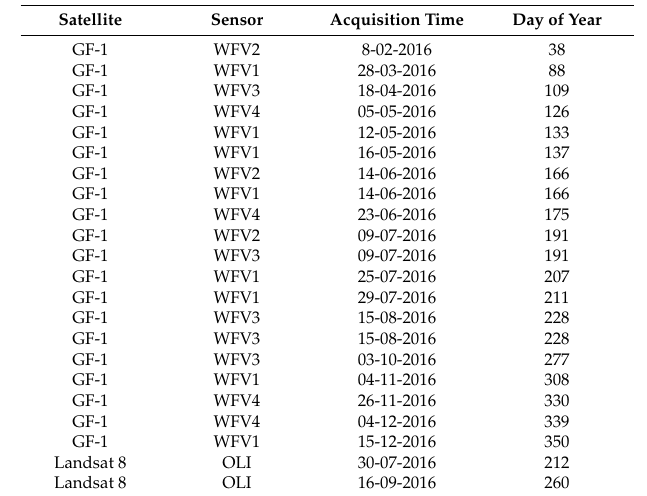
Table 2. Information for the medium-resolution images that were used in the study. (WFV1 for NO.1 WFV sensor in GF-1, and so on.)